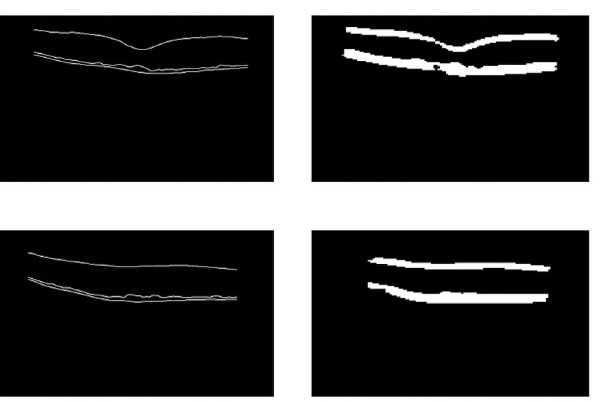
Fig 7. The U-Net results. On the left, the original image of the mask, and on the right, the result of the network.